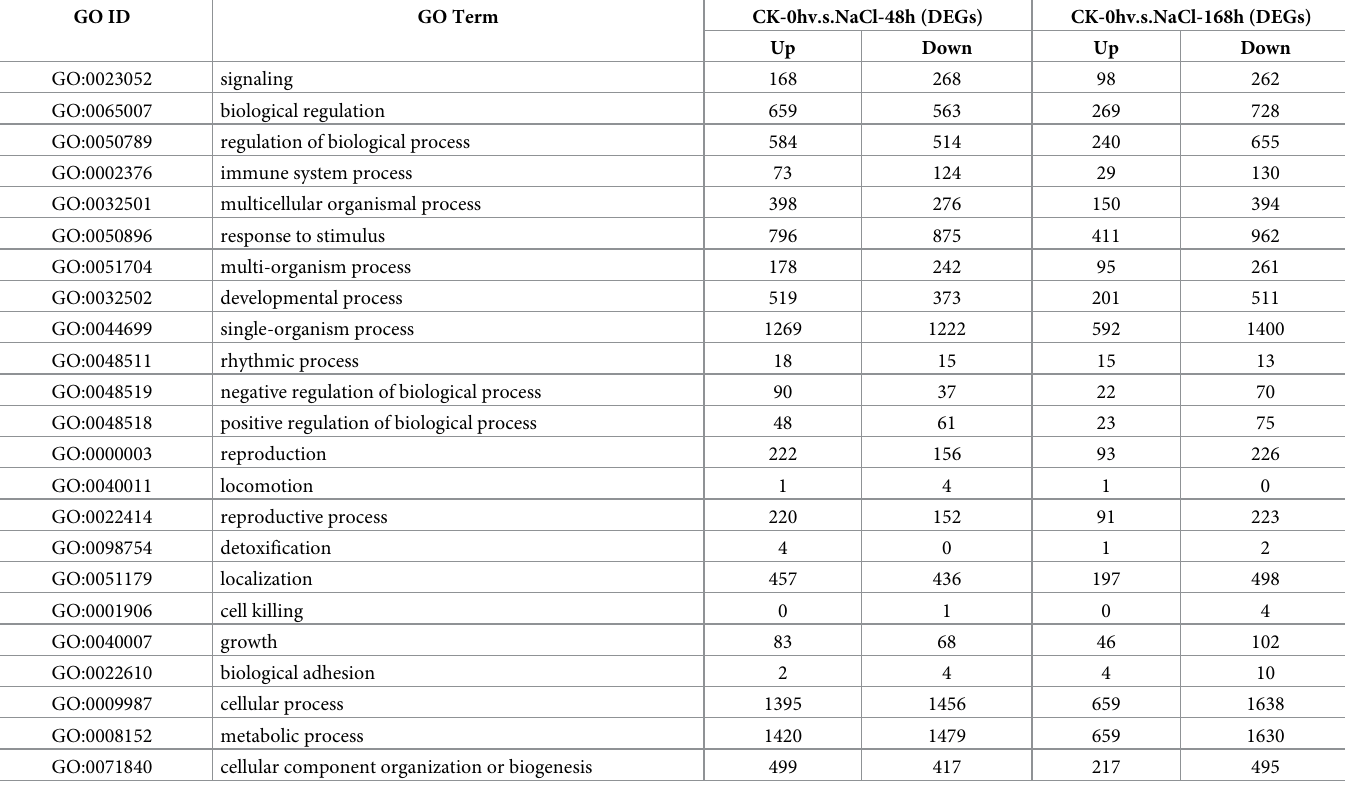
Table 2. GO enrichment analysis of the biological process of DEGs.